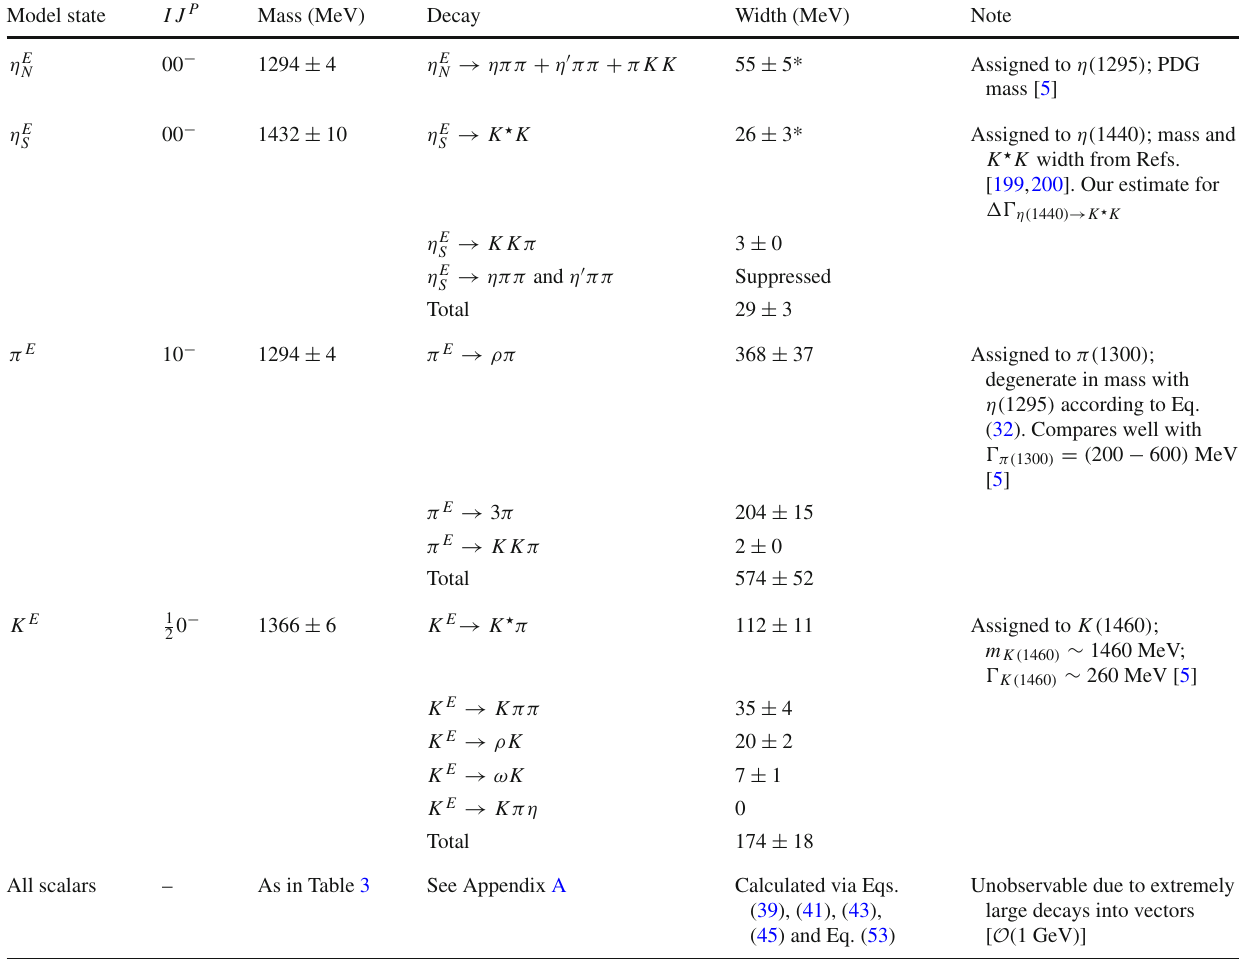
Table 5 Decays and masses for the case where η( 1295 ) and η( 1440 ) are enforced as excited ¯ qq states. Widths marked with an asterisk were used as input. Pseudoscalar observables compare fine with experiment